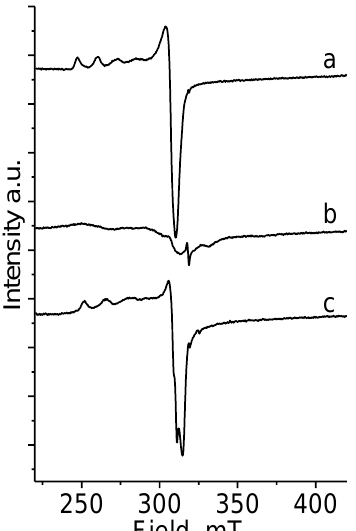
Figure 4. EPR spectra of Cu-SBA-15 fresh sample (a), after evacuation at 623 K (b) and after adsorption of NO (c). Spectra recorded at 77 K.